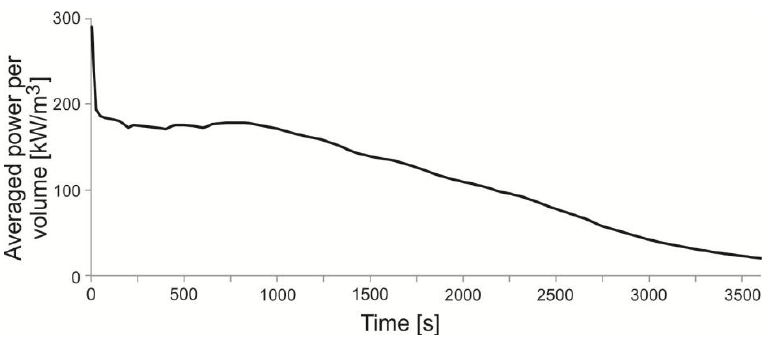
Figure 9. Chronological sequence of the volume averaged charged power during the melting process.